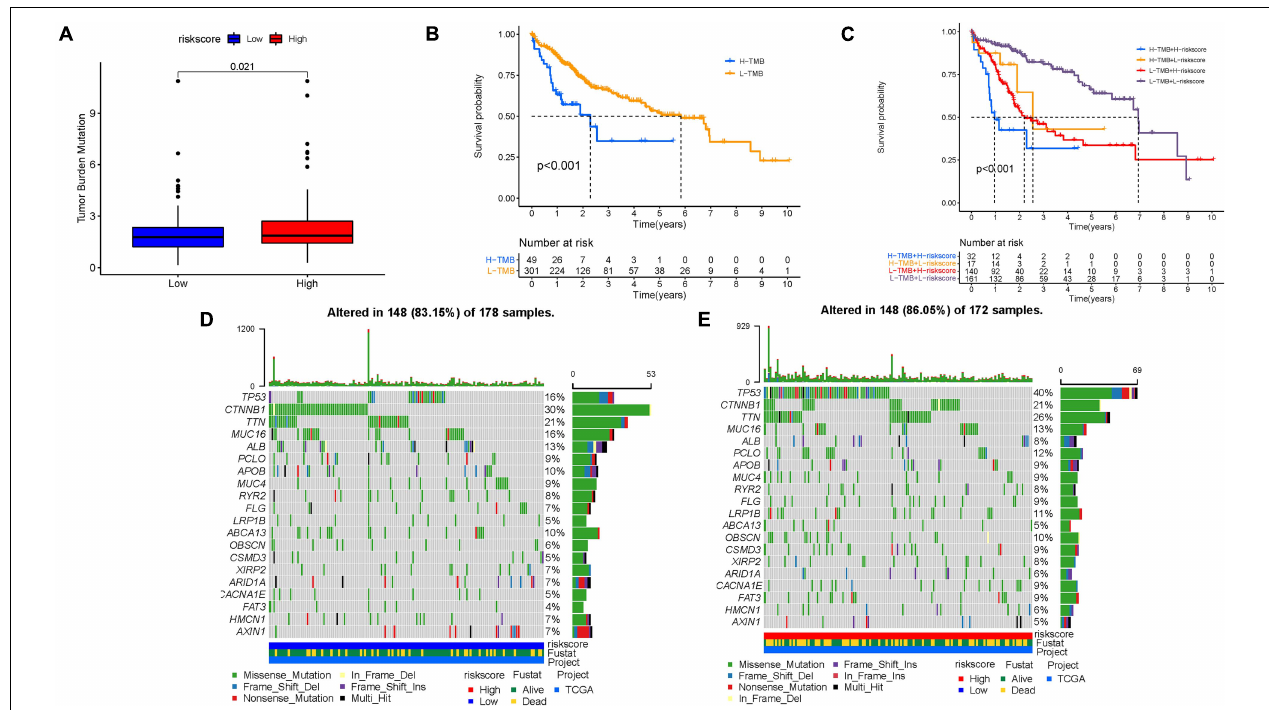
FIGURE 8 | Characteristics of stemness-based risk score in tumor somatic mutation. (A) Difference of TMB between patients from the low-/high-risk score subgroups. (B) Kaplan–Meier curves for high and low TMB groups. (C) Kaplan–Meier curves for patients stratified by both TMB and risk score. The oncoPrint was constructed using low-risk score (D) and high-risk score (E) .